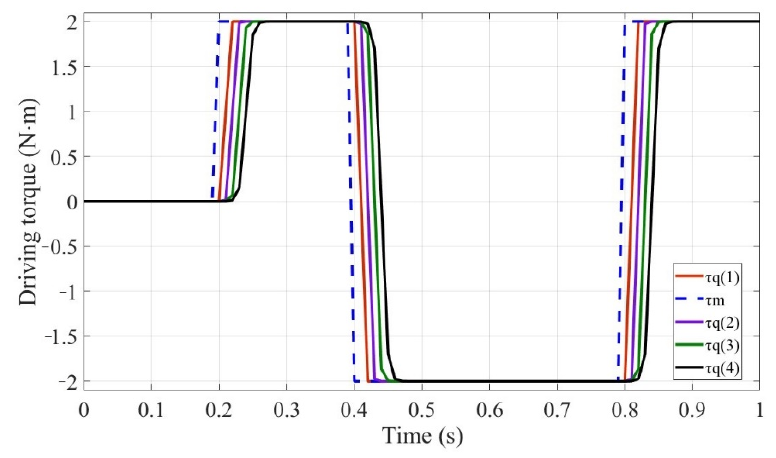
Figure 5. The tracking situation of the virtual torque with different numbers of steps.